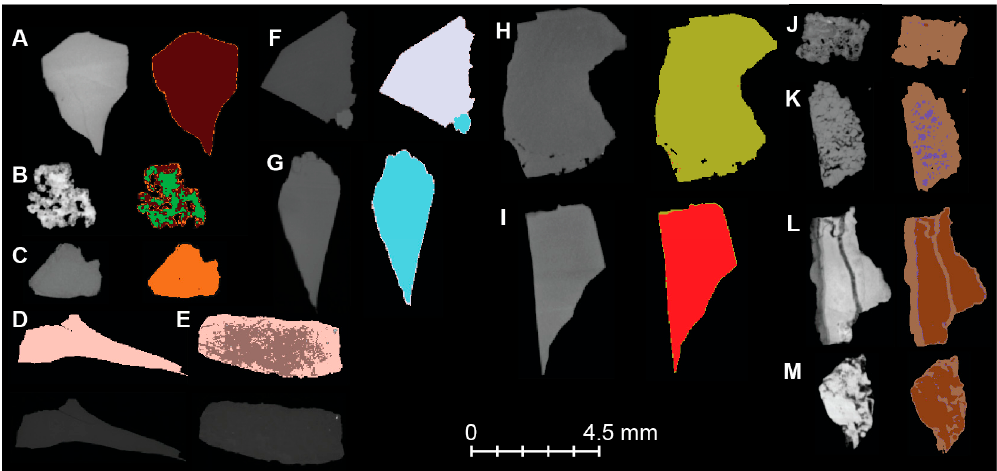
Figure 6. Grey value variation of different minerals with their corresponding false colour to illustrate discrimination between minerals at 45.5 keV effective energy: ( A ) almandine, ( B ) andradite, ( C ) grossular, ( D ) quartz, ( E ) kaolinite, ( F ) dolomite, ( G ) calcite, ( H ) apatite, ( I ) fluorite, ( J ) goethite, ( K ) chromite, ( L ) magnetite and ( M ) hematite. Table 2. Comparison of the NIST and MXLAC attenuation coefficients for different types of minerals.